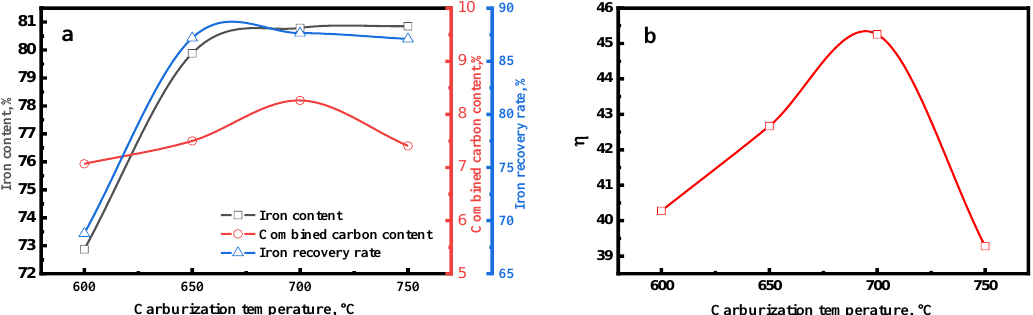
Figure 7. Effect of carburization temperature on the ( a ) magnetic concentrate and ( b ) carburization index of carburized pellet (carburized for 150 min with 20% Na 2 SO 4 ).